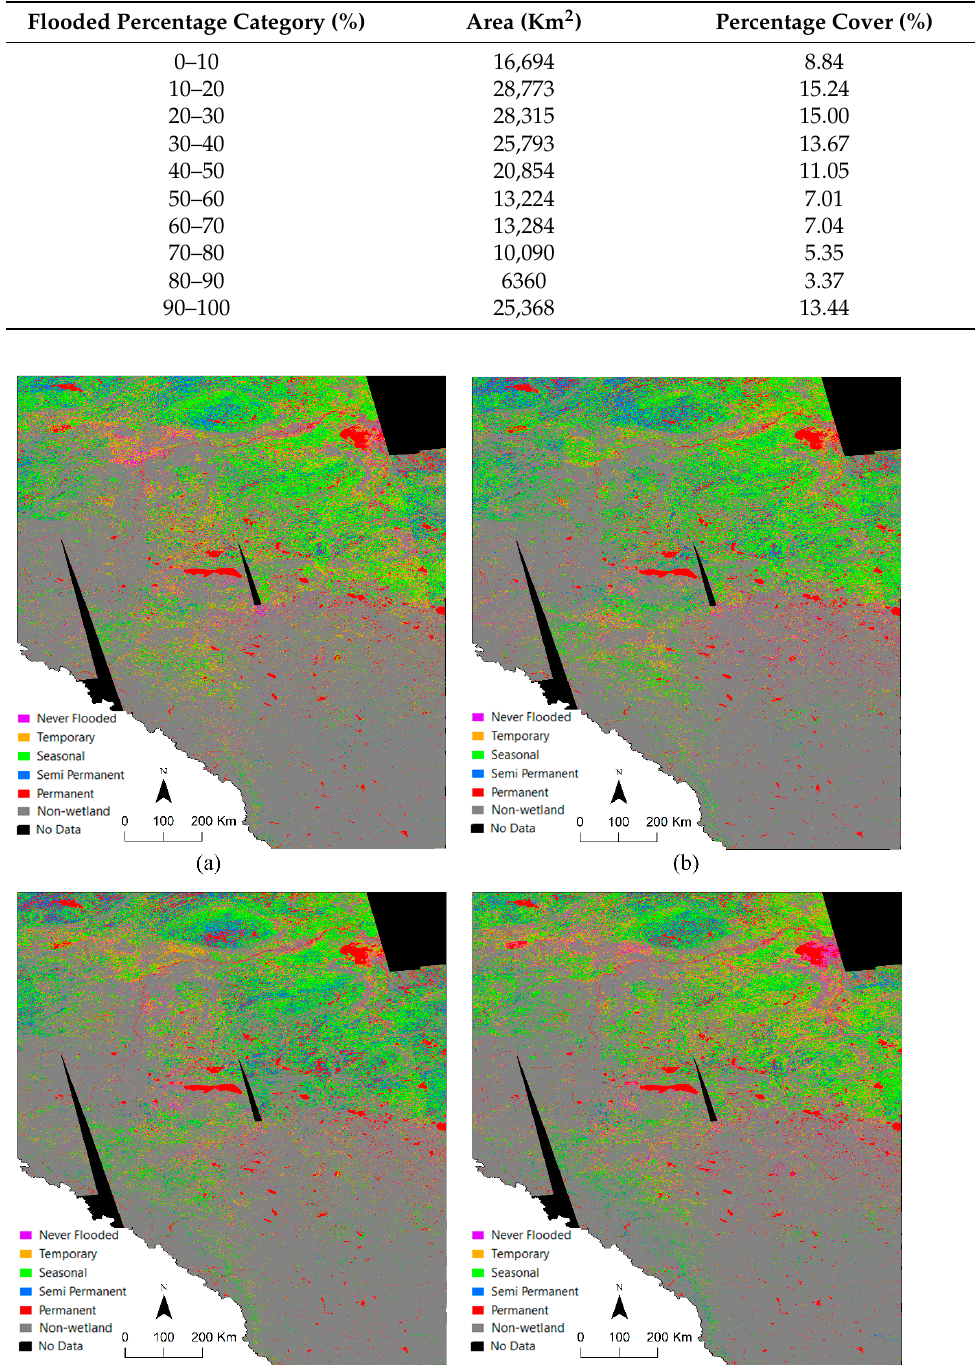
Table 2. Areas of flooded wetlands between 2017 and 2020 for different hydroperiod categories.